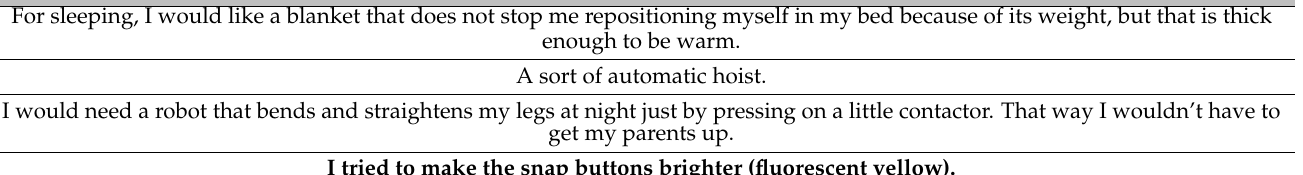
Table 5. Examples of desired solutions described in the responses to open questions (in bold style: responses from relatives; in italic style: responses from professionals; in regular style: responses from children and youth with